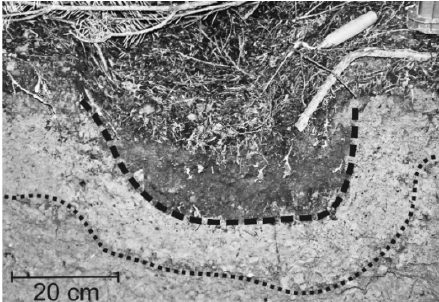
Figure 7. Filling of wheel rut with loose organic and mineral material at the study site BIB (21). The bold dashed line indicates the boundary of the former depression zone. The transition to the unbleached mineral soil is marked by the dotted line (photograph: H. Buberl).